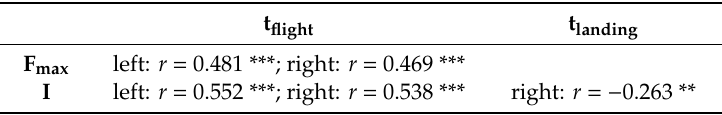
Table 1. Correlations between the impulse and normal GRF max of the left and right leg, and t landing and t flight for the 101 collected jumps.